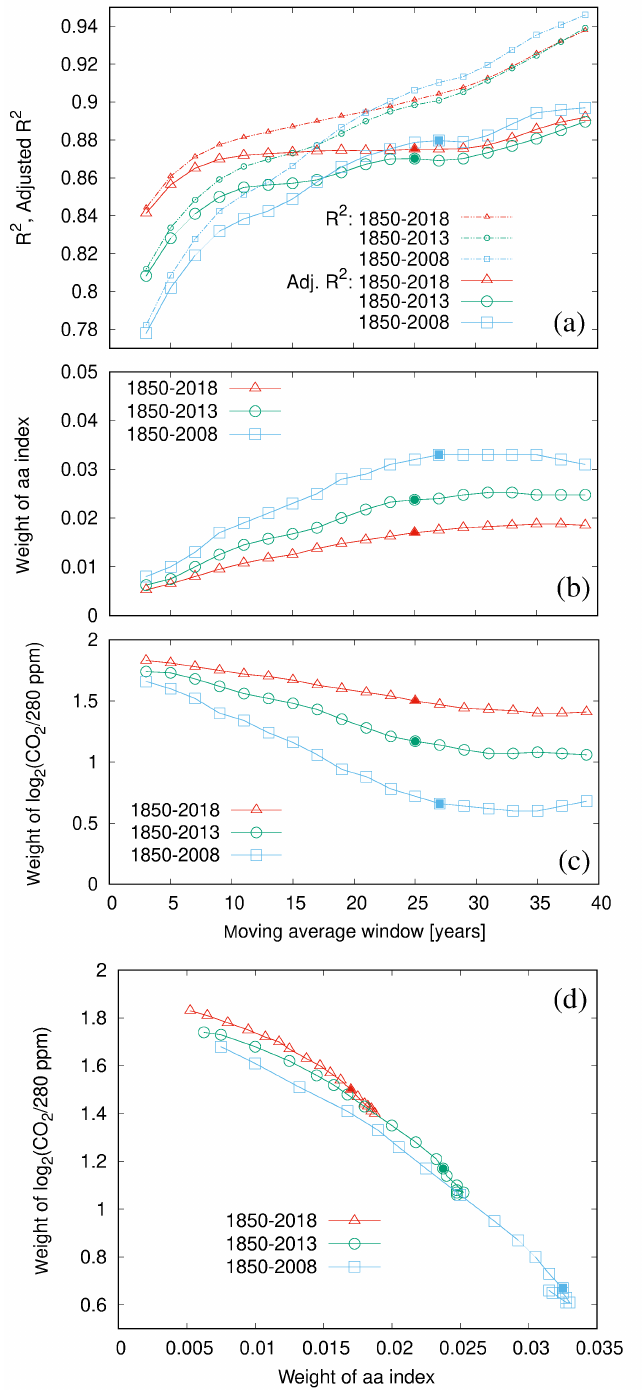
Figure 7. Results of the regression in dependence on the width of the moving average window (MAW). ( a ) R 2 and its adjusted version R 2 , each for the three time intervals ending in 2018, 2013, 2008. The (shallow) local maxima of R 2 around MAW = 25years are indicated by full symbols. ( b ) w aa in dependence on MAW. The full symbols are the values corresponding to the local maxima in ( a ). ( c ) Same as ( b ), but for w CO . ( d ) Regression result in the two-dimensional parameter space of 2 w aa and w CO . Note the universal shape of the solution resulting in a slightly bent, but nearly linear 2 ≈ 1.9K on the ordinate axis and w aa ≈ 0.04K/nT on function connecting the extremal values w CO 2 the